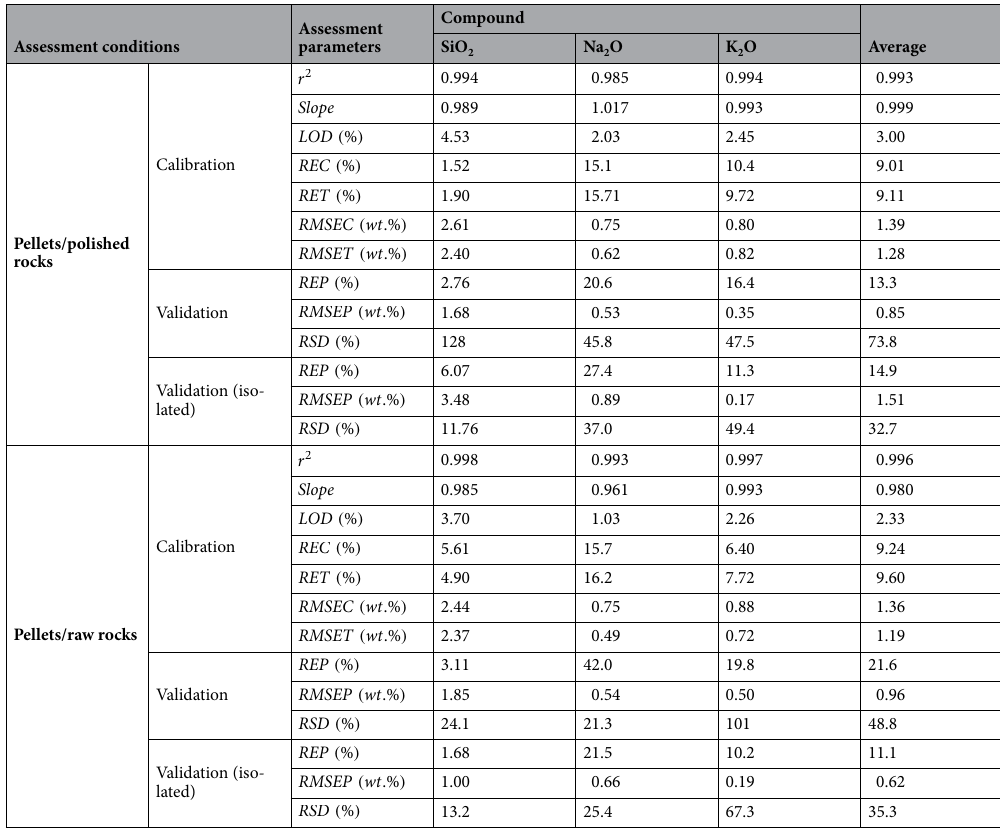
Table 3. Parameters assessing the calibration and prediction performances of the transfer learning calibration models for SiO 2 , Na 2 O and K 2 O.